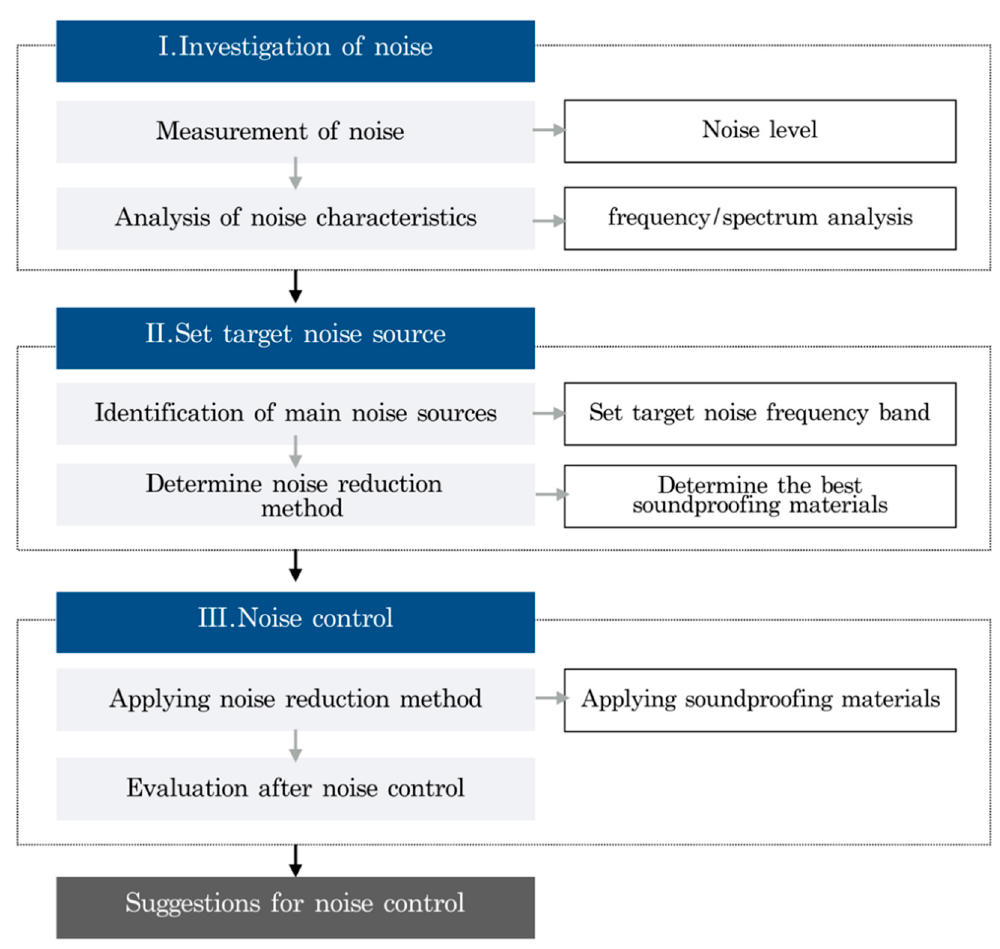
Figure 1. The noise control method process involving the application of soundproofing material to the milling machine. milling